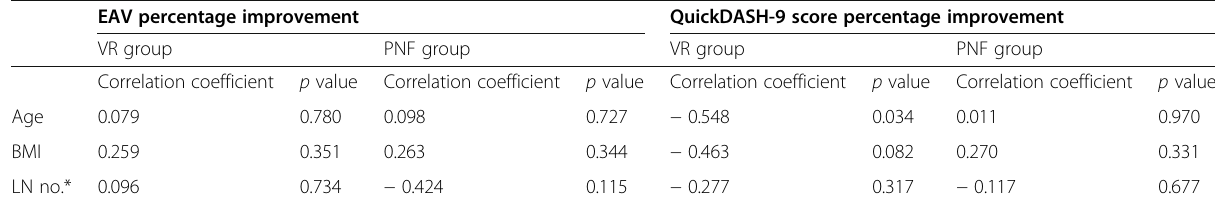
Table 3 Relationships between the percentage EAV improvement and percentage functional improvement and patient age, BMI, and number of dissected lymph nodes